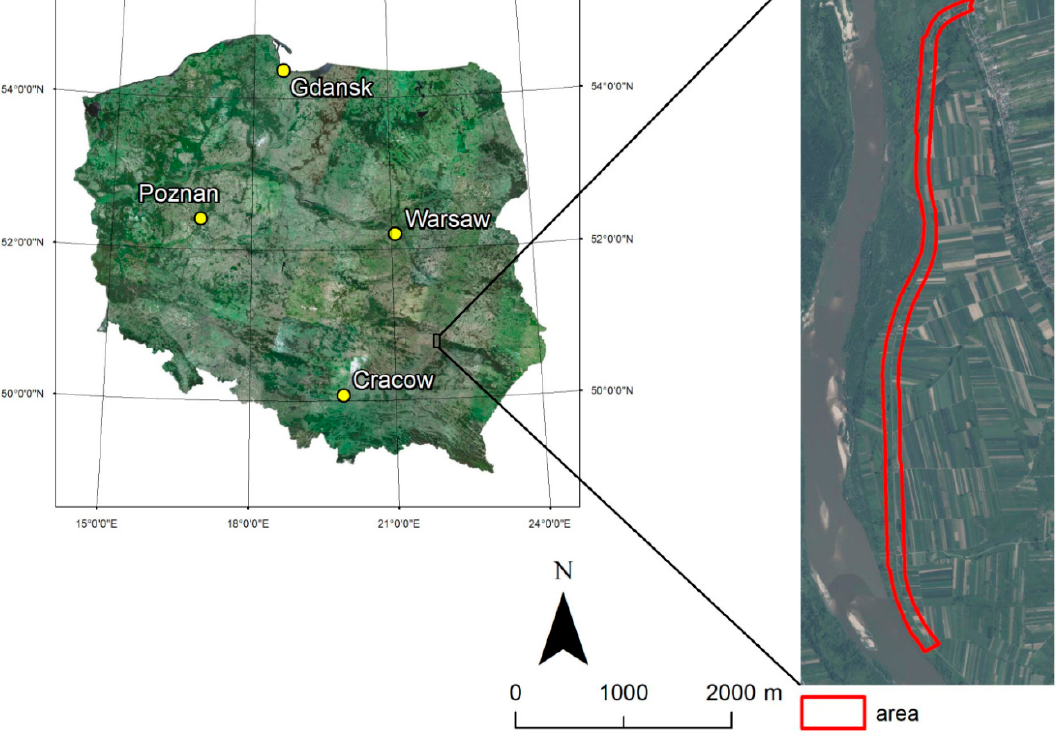
Figure 2. The location of the area of interest in Poland: Levee in Annopol, located on the Vistula